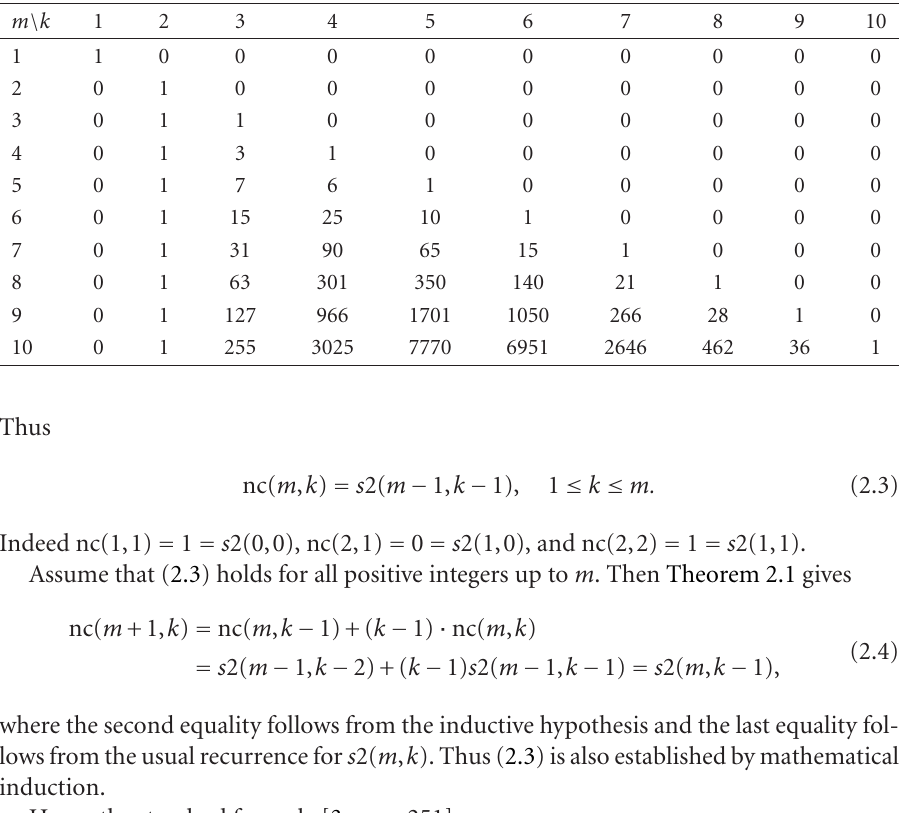
Table 2.1. Values of nc( m , k ) for m = 1, ... ,10, k = 1, ...